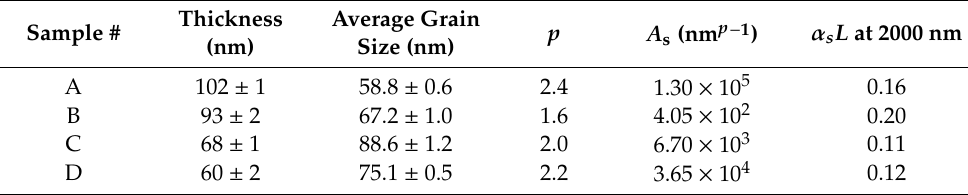
Table 2. The scattering contribution to attenuation in VO 2 films on Si, given E g = 0.60 eV and A a = 0.0048 nm − 1 · eV − 1